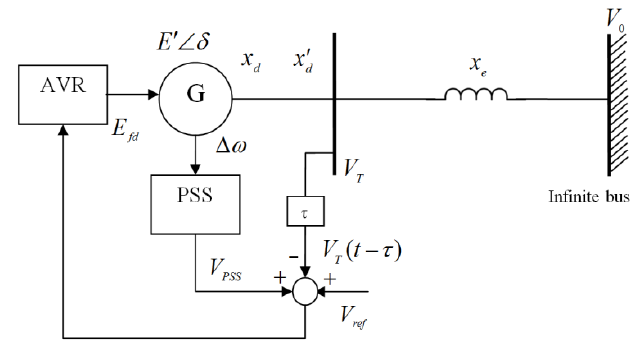
Figure 2. A single-machine-infinite-bus power system with an